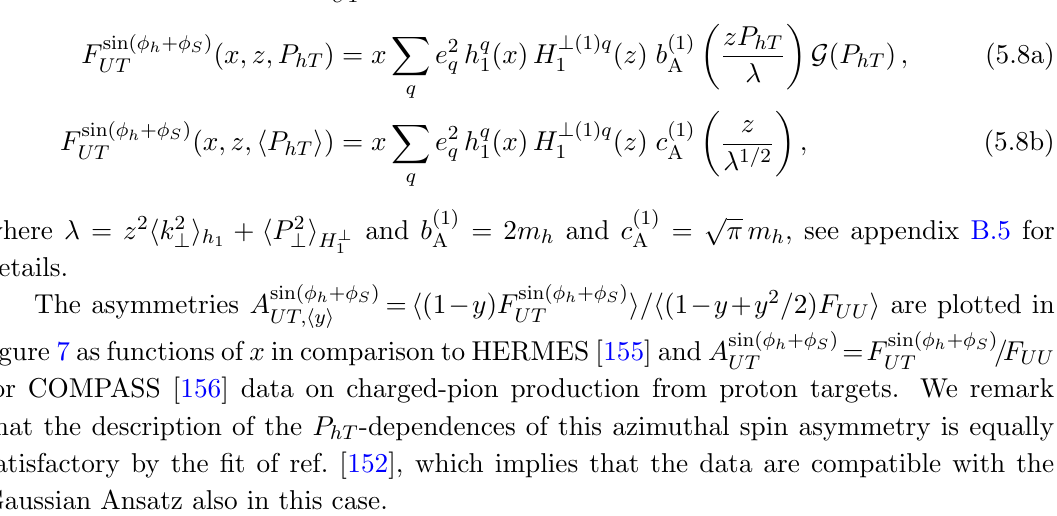
in comparison to COMPASS [156] UT